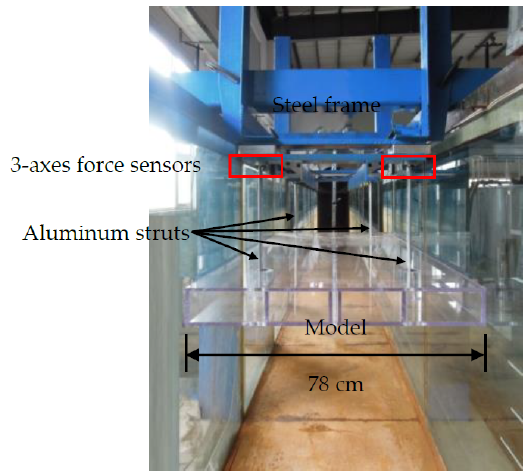
Figure 2. The model attached to the V-shape struts and connected to force sensors installed on a steel frame. The width of the leading edge of the model was 78 cm with a 1 cm gap at the sidewalls.